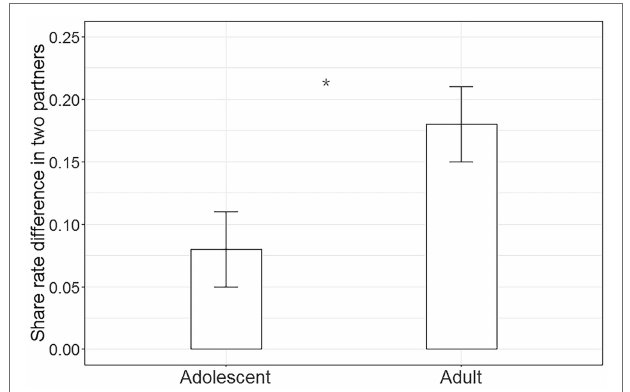
FIGURE 3 | Age effect on the share rate difference. Adolescents’ percentage difference between trials in which shared with good-to-neutral and bad-to- neutral was significantly smaller than that of the adult group (error bars reflect SE, * p <